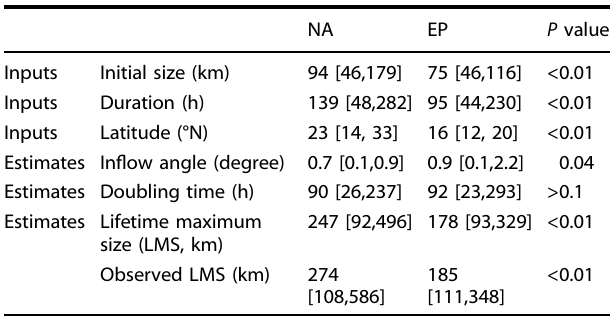
Table 3. Statistics of the growth factors. Table 4. Validation of the growth model by fi tting to the size growth of individual storms globally.